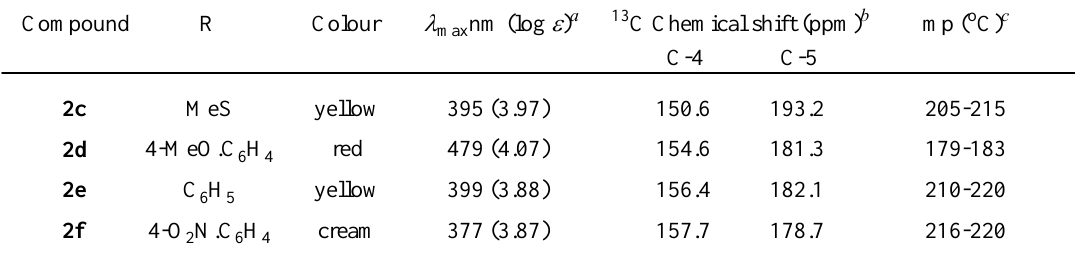
Table 2 Selected properties for the 1,2,3-dithiazolium perchlorates 2 Compound